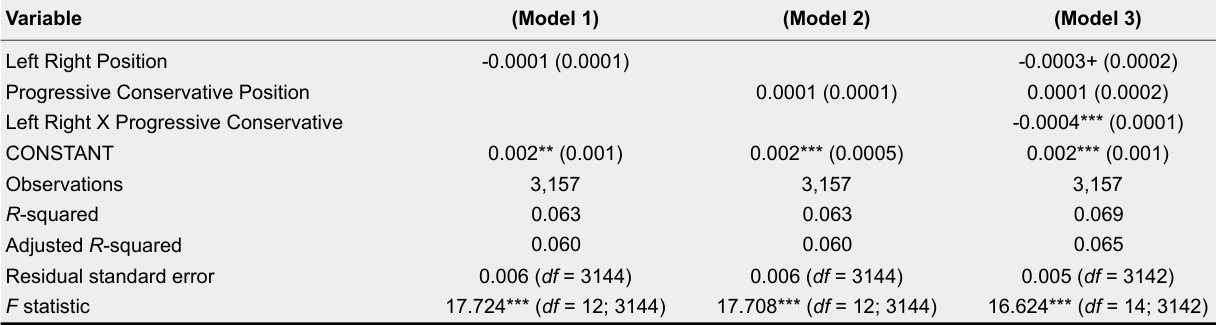
OLS Model of Proportion of Numbers on Speaker Ideology